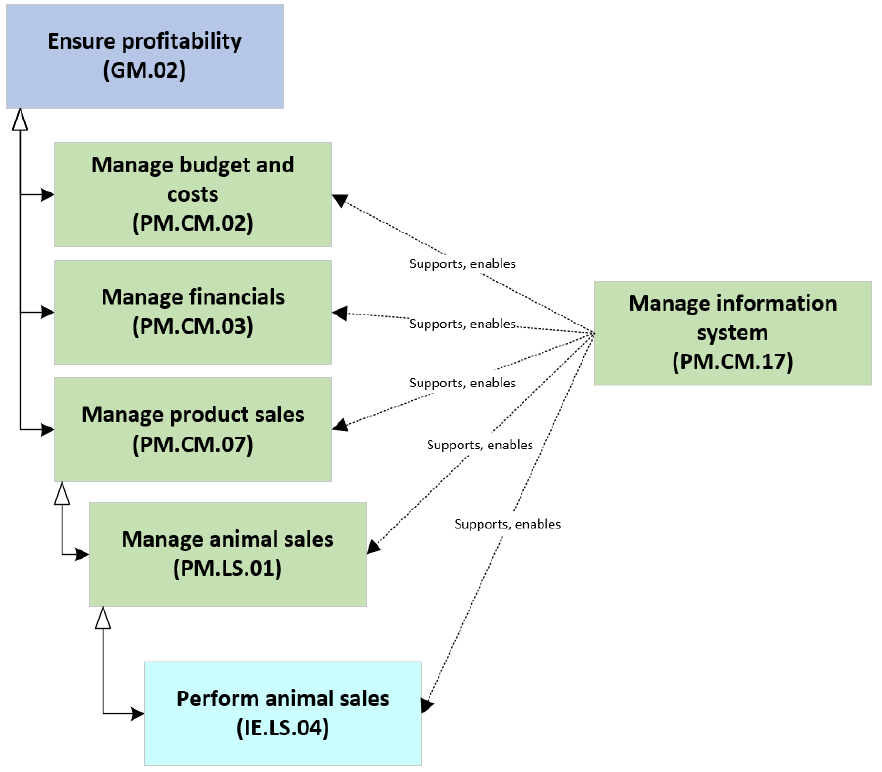
Figure 4. Example of relations between processes. Table 1. The list of processes in RSPMA.